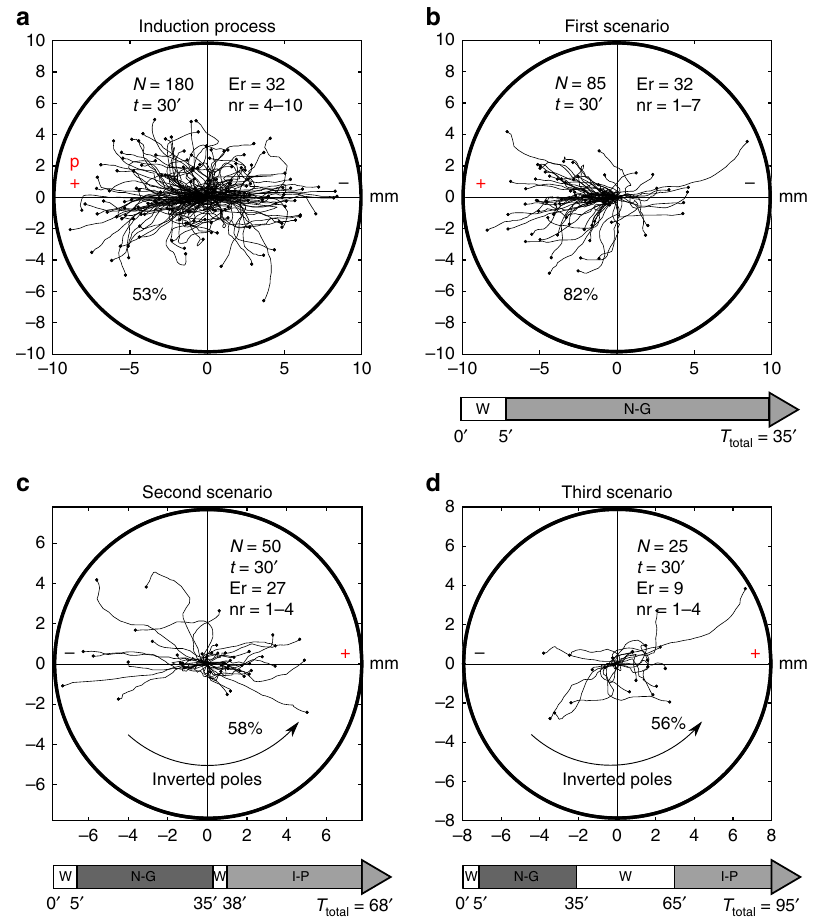
Fig. 4 Experimental evidences of conditioned behavior in Amoeba proteus . a Under galvanotaxis and chemotaxis simultaneously, 53% of the amoebae moved towards the anode-peptide (induced cells). b First scenario (after induction process, the cells were exposed to 5 min without stimulus and 30 min on galvanotaxis), 82% of the induced cells presented lasting directionality towards the anode where the chemotactic peptide was absent. c Second scenario (after induction process, the cells were exposed to 5 min without stimulus, 30 min on galvanotaxis, 3 min without stimulus and 30 min on galvanotaxis with inverted polarity), 58% of the induced cells continued migrating towards the positive pole, now in the opposite side. d Third scenario (after induction process, the cells were exposed to 5 min without stimulus, 30 min on galvanotaxis, 30 min without stimulus and 30 min on galvanotaxis with inverted polarity), 56% of the induced cells still maintained the migration towards the positive pole. “ N ” total number of cells, “ Er ” experimental replicates, “ nr ” number of cells per replicate, “ t ” galvanotaxis time, “ T ” total time after induction process, “ p ” chemotactic peptide (nFMLP), “ + ” anode, “ − ” cathode. “ W ” without stimulus, “ N-G ” normal galvanotaxis, “ I-P ” galvanotaxis with inverted polarity. In all the diagrams, the tracking has been represented up to the maximum value obtained towards the positive or negative pole. Both the x and y axis show the distance in